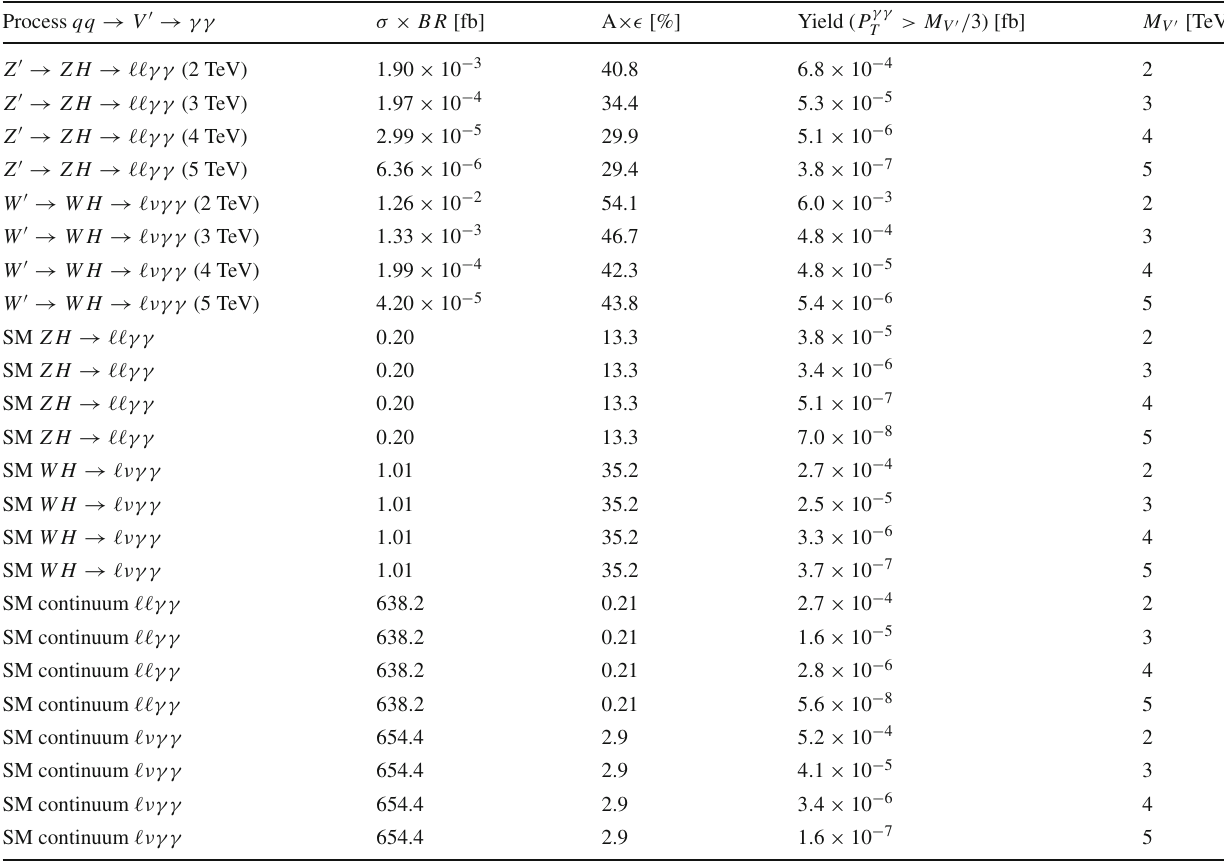
Table 1 Non-local anomalous Higgs production yields for a = 1 in fb, compared to SM Higgs and continuum SM background yields for searches targeting resonance masses of 2, 3, 4 and 5